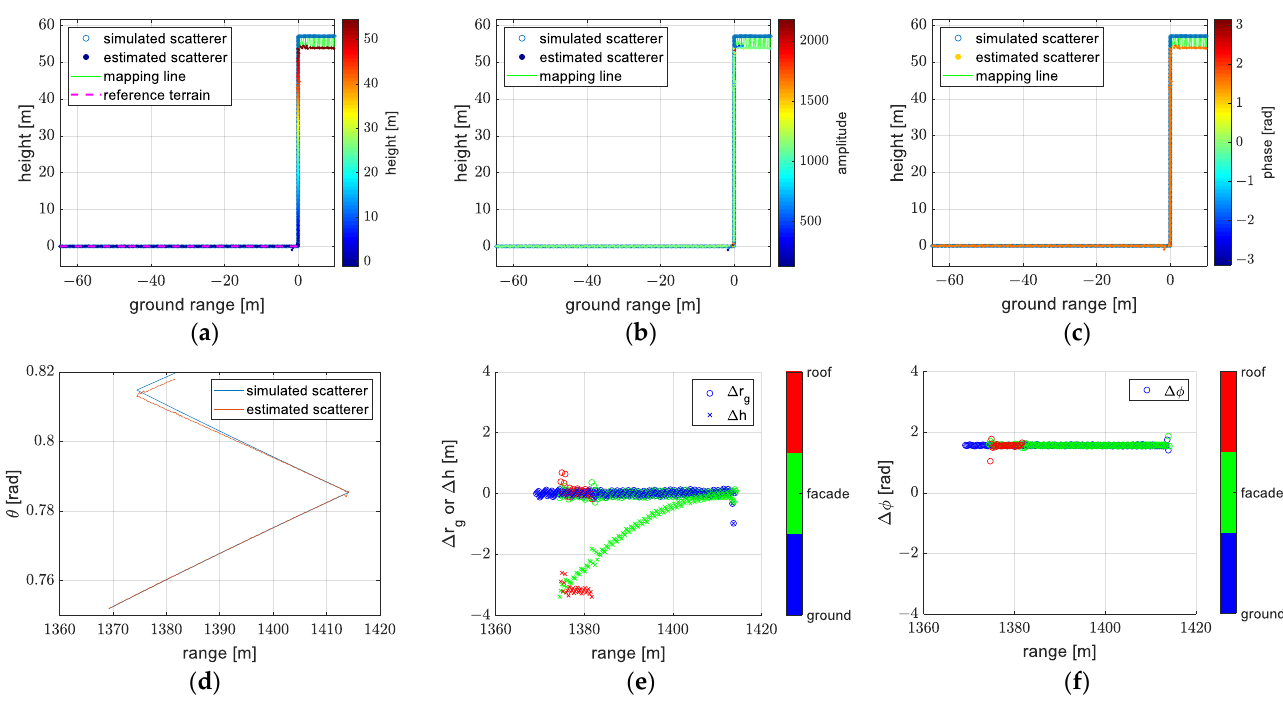
Figure 13. The reconstruction obtained using model 4 (the third approximate form of the planar wavefront model): ( a ) reconstruction with colors denoted as height, ( b ) reconstruction with colors denoted as amplitude, ( c ) reconstruction with colors denoted as phase, ( d ) the off-nadir angle of the reconstruction, ( e ) the error of the ground range and height, ( f ) the error of the phase. The reconstructions obtained using the exact and approximate forms of the spherical wavefront model are shown in Figures 14 and 15. The results of these two models are generally consistent. We can see that positions of estimated scatterers almost coincide with positions of simulated scatterers, and the amplitude and phase of estimated scatterers are almost constant. The correctness of the spherical wavefront model is proved.